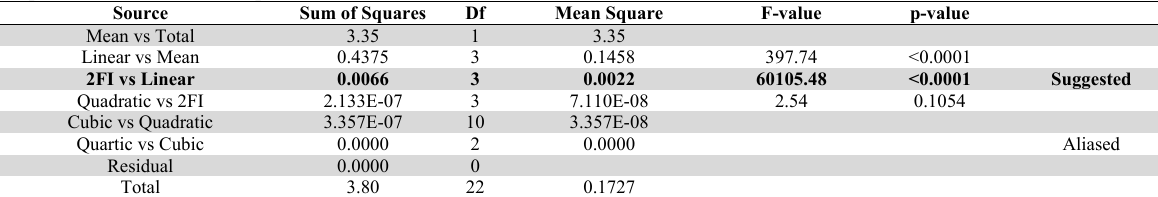
Sequential model sum of squares